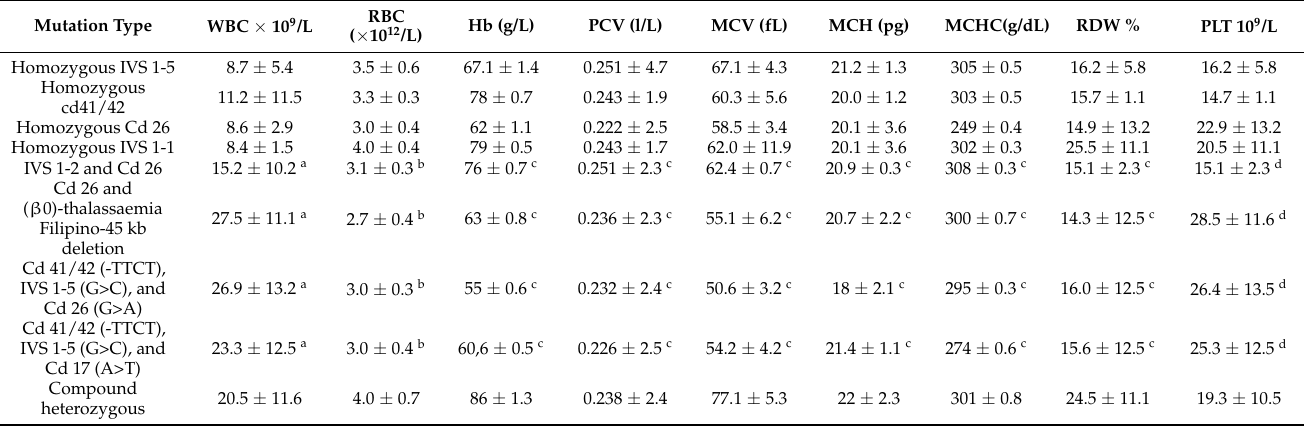
Table 6. Haematological characteristics according to the mutation types of HbE/ β -thalassaemia patients.